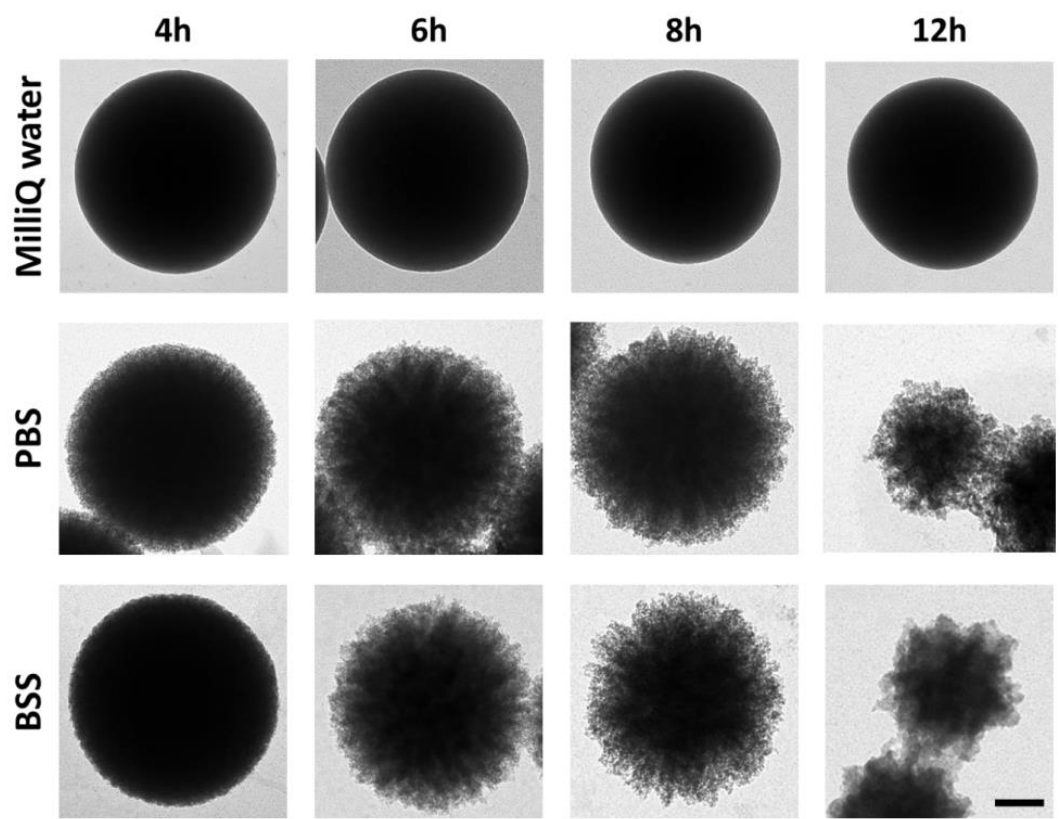
Figure 1. Degradation of mesoporous silica particles (MSPs) in different media. Representative transmission electron microscopy (TEM) images of bare MSPs after incubation at 37 °C for 4, 6, 8, and 12 h in MilliQ water, phosphate-buffered saline (PBS), or a balanced salt solution (BSS). All images are taken at the same magnification. The scale bar is 100 nm.